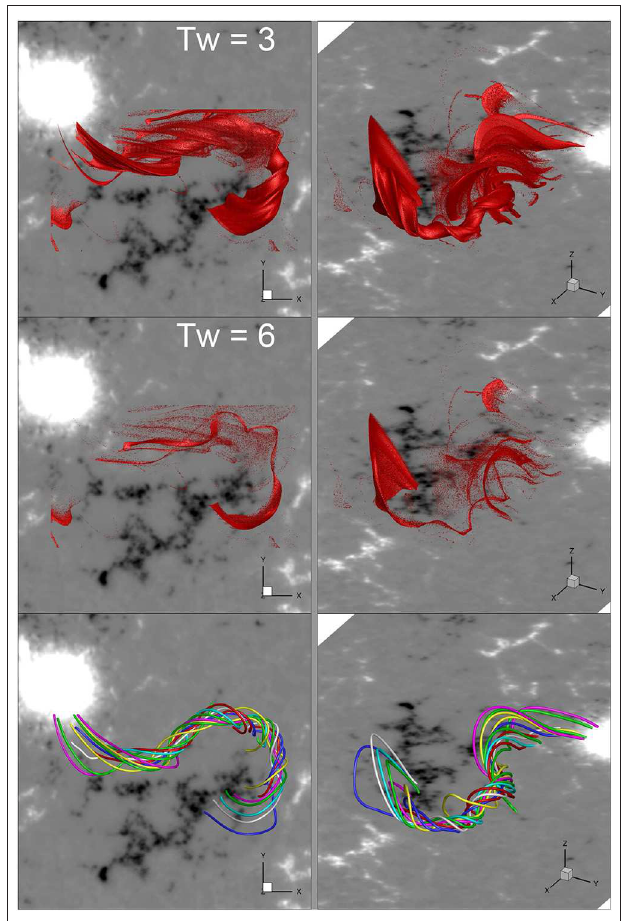
FIGURE 3 | Top : iso-surface of magnetic twist number T w = 3 in two different angles of view. Middle : iso-surface of magnetic twist number T w = 6. Bottom : sampled magnetic field lines of the MFR in different views. Note that the lines colored in white represent the axis of the rope, i.e., the one that possesses the maximum value of T w =